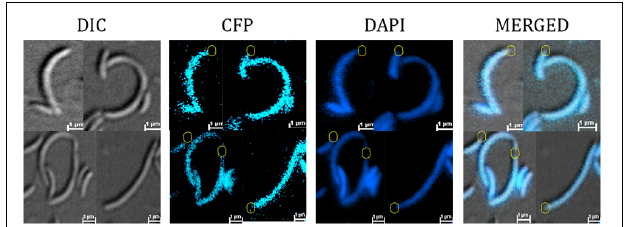
FIGURE 3 | YbaB Cc colocalizes with nucleoid in vivo . RP44 cells (CB15N cc2570 :pTC67 ftsI (Ts) xyl X:pXCFPN-5- ybab Cc ) were cultured at 30 ◦ C for 1 h and then shifted to the restrictive temperature (37 ◦ C) for 4.5 h in PYE medium, followed by DAPI staining and imaging on agarose-padded glass slides. Fluorescence imaging shows YbaB Cc -CFP colocalizing with DAPI-stained nucleoid in a temperature-sensitive PBP3 mutant Caulobacter crescentus . DNA-free regions devoid of both DAPI and CFP signal are depicted in circles